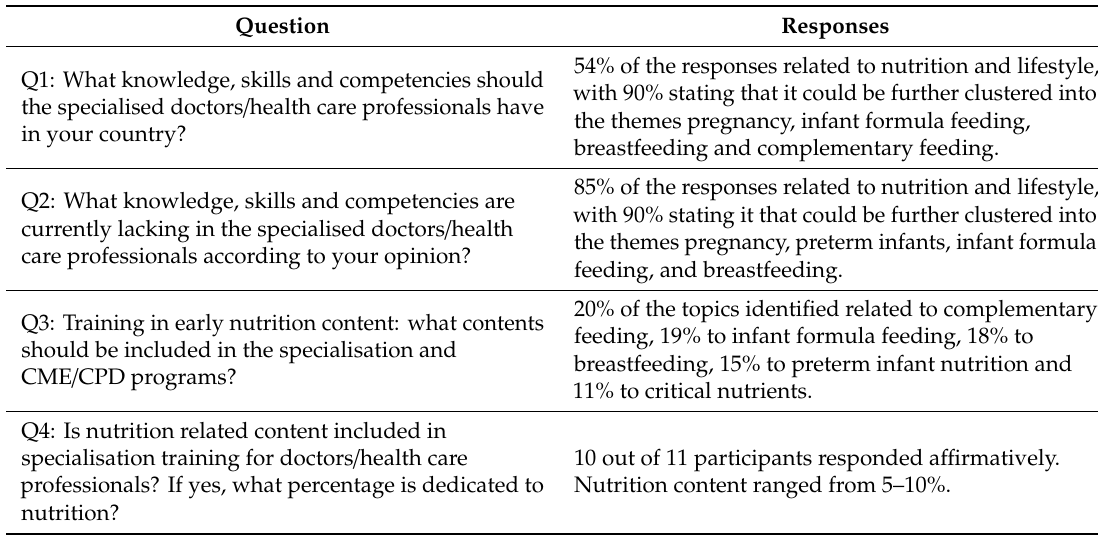
Table 2. Questions and participant responses in the open questionnaire to stakeholders with an influencing role on CME / CPD